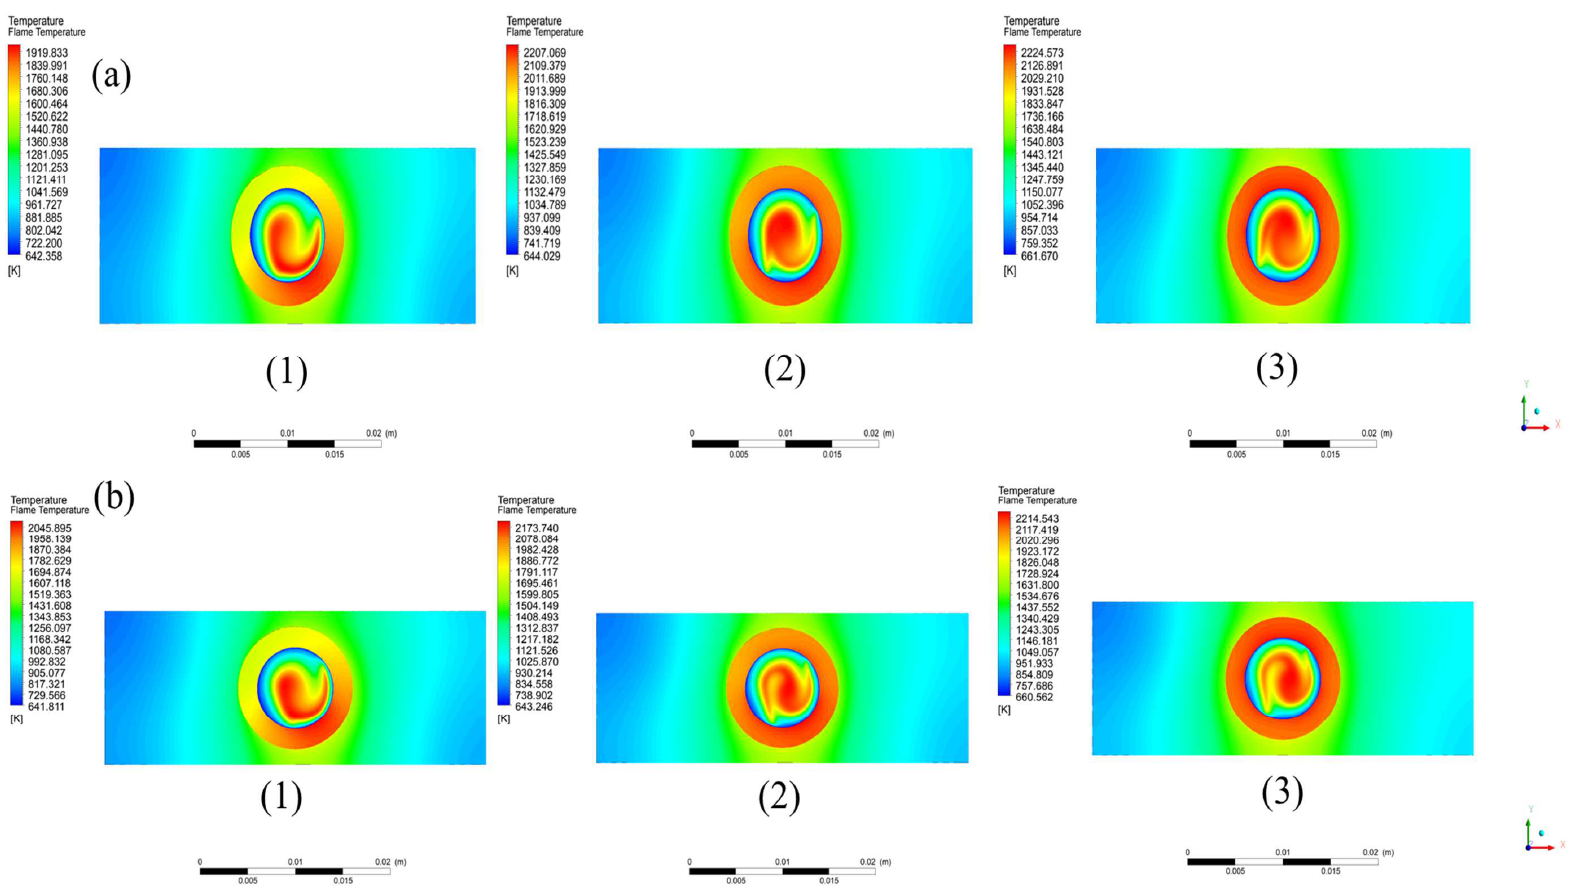
Figure 9. The vertical vortex combustor flame temperatures for ( a ) aluminum and ( b ) stainless steel material with fuel velocity 0.2; ( 1 ) air velocity 0.6, ( 2 ) air velocity 1.0, and ( 3 ) air velocity 1.4 m/s .